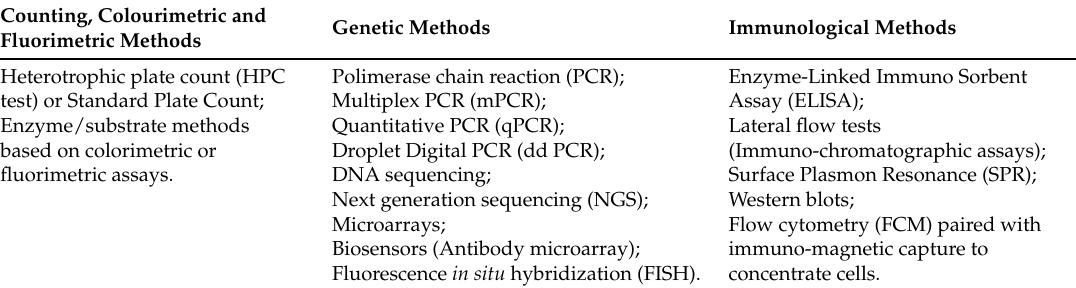
Table 1. Methods currently used for the detection of water pathogens. Counting, Colourimetric and Genetic Methods Immunological Fluorimetric Methods